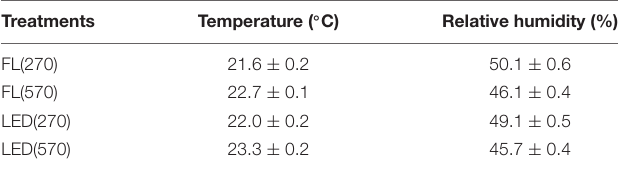
TABLE 1 | Environmental data for the treatments reported.